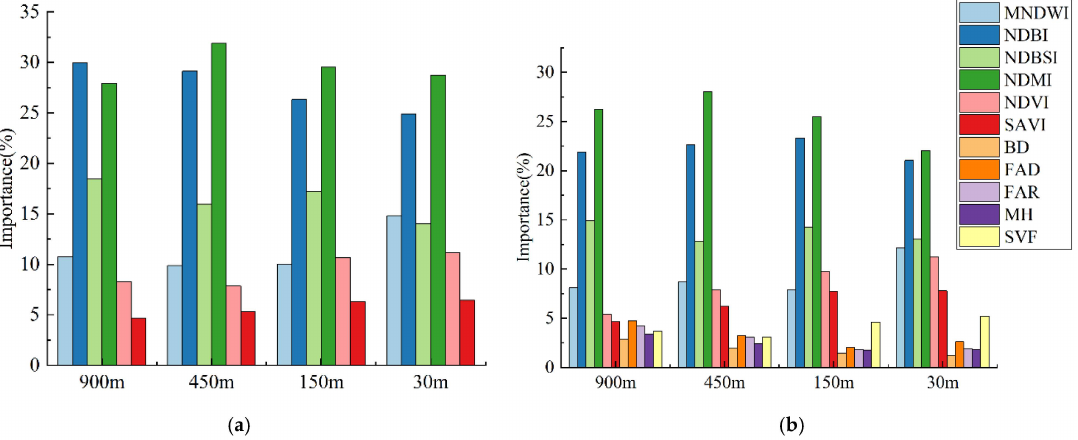
Figure 9. Importance of each driver at spatial resolutions of 900, 450, 150 and 30 m. ( a ) No spatial morphological parameters added. ( b ) Spatial morphological parameters